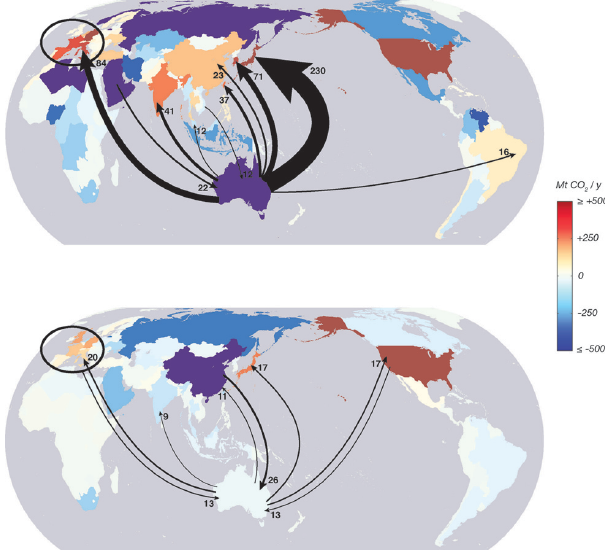
Fig. 15. Millions of tons (Mt) of CO 2 embodied in trade in 2004. The upper panel shows regional differences between extraction and production emissions (i.e. the net effect of emissions from traded fossil fuels), and the lower panel shows regional differences be- tween production and consumption emissions (i.e. the net effect of emissions embodied in goods and services). Net exporting coun- tries are shown in blue and net importing countries in red. Arrows in each panel depict the fluxes of emissions (MtCO 2 yr − 1 ) to and from Australia greater than 9Mt CO 2 yr − 1 . Fluxes to and from Eu- rope are aggregated to include all 27 member states of the European